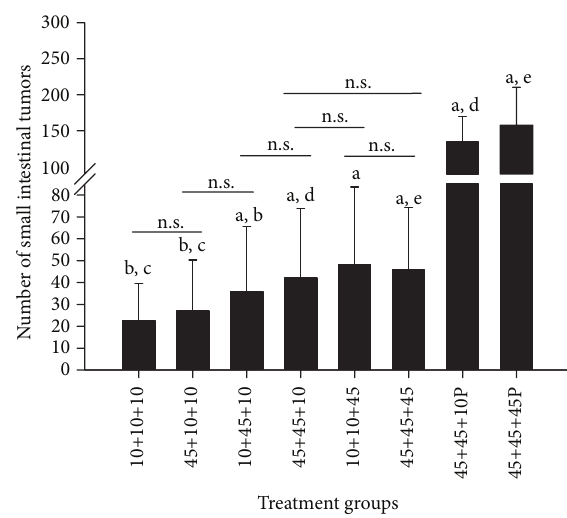
Figure 9: The number of small intestinal tumors for pooled male and female Min/+ mice (mean ± SD). Two separate experimental groups receiving a 45% fat diet during in utero and nursing period or throughout life were injected with PhIP (marked P). The experimental groups are as explained in the legend to Figure 1. 𝑛 = 44 – 65 . a Significantly different from the negative control group given a 10% fat diet throughout life. b Significantly different from the group given a 45% fat diet throughout life. c Significantly different from the group given a 45% fat diet in utero and during nursing. d Significantly different with PhIP compared with no PhIP exposure in the groups given a 45% fat diet during in utero and nursing period. e Significantly different with PhIP compared with no PhIP exposure in the groups given a 45% fat diet throughout life. n.s. = not significantly